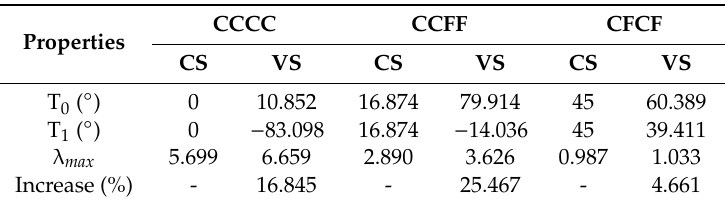
Table 16. Optimal angles of a single layer VS plate for maximum biaxial load multipliers, with clamped boundary conditions.